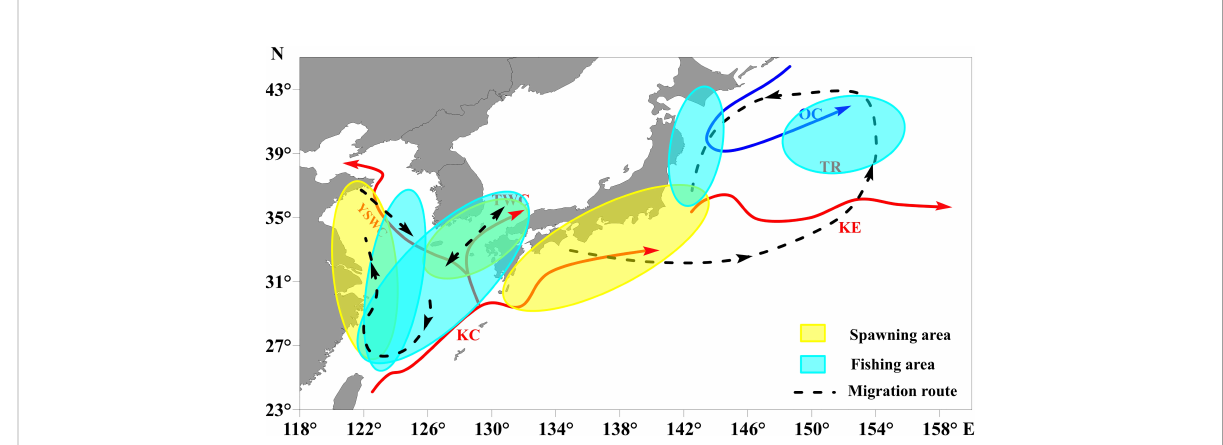
FIGURE 2 Schematic diagram showing main spawning areas, fi shing areas, and migration route of chub mackerel and the oceanographic structure in the northwest Paci fi c Ocean. (YSWC, Yellow Sea Warm Current; TWC, Tsushima Warm Current; KC, Kuroshio Current; KE, Kuroshio Extension; TR, Transition Region; OC, Oyashio Current). Red and blue solid lines represent the warm and cold currents, respectively. Yellow and blue shaded areas indicate the main spawning and fi shing areas of chub mackerel, respectively, and dotted lines with arrows represent their migration